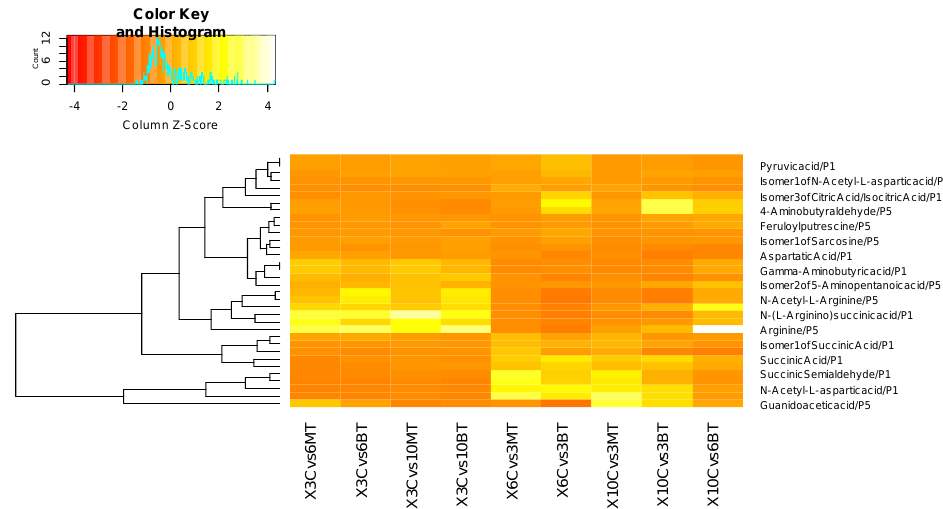
Figure 6. Heat map showing some of the differentially expressed metabolites of Glyoxylate and Dicarboxylate metabolism (P42) and Lysine degradation (P50) pathways in different comparisons between positive control plants (C) and Metarhizium (MT) or Beauveria (BT) treatments at different Dpi. Z score is a measure of distance, in standard deviations, from the plate mean. A well with a Z score of 0 has the same raw value as the plate mean. A well with a Z score of 1.0 is exactly one standard deviation above the plate mean and a Z score of −0.5 is half a standard deviation below the plate mean.